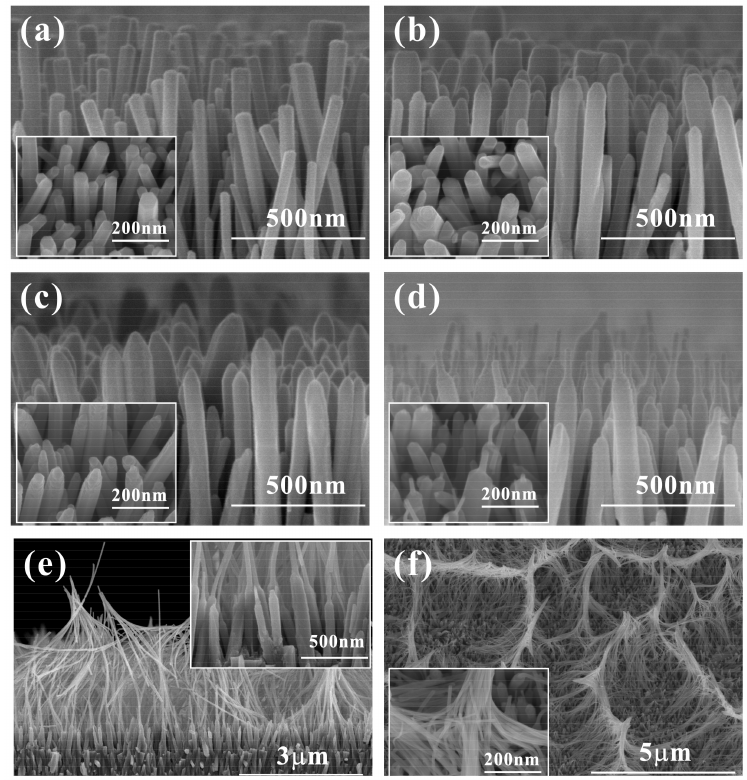
Figure 1. The cross-section and top view (inset) images of the ZNAs synthesized with 0.05 M precursor concentration in T1 for 2 h and 0.01 M in T2 for: ( a ) 0 h (H-0); ( b ) 1 h (H-1); ( c ) 2 h (H-2); ( d ) 4 h (H-4); and ( e ) the cross-section and ( f ) the top view images of the ZNAs synthesized with 0.05 M precursor concentration in T1 for 2 h and 0.01 M in T2 for 10 h (H-10). The insets are their high-magnification images.